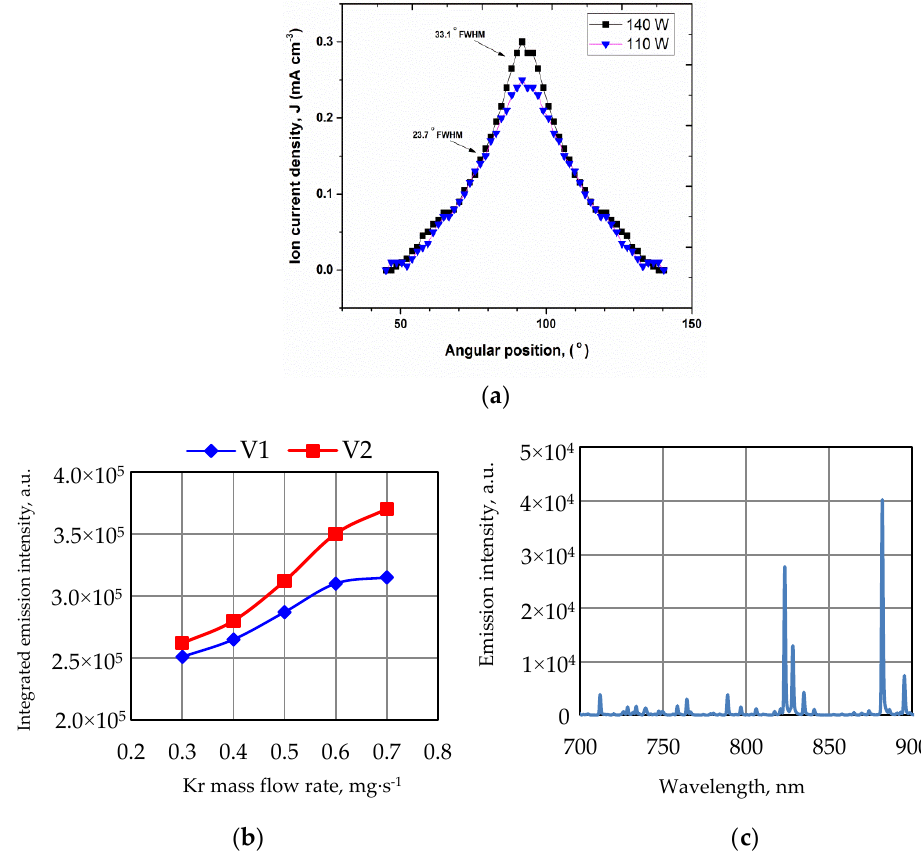
Figure 5. Plasma plume diagnostics for a Kr-fed low-power Hall thruster: ( a ) ion current density profiles for two operating conditions. © [2018] IEEE. Reprinted, with permission, from Lim et al., IEEE Transactions on Plasma Science 46, 2 (2018) [22]; ( b ) integrated optical emission intensity (300–1100 nm) as a function of the propellant flow rate, at two operating voltages 𝑉 1 = 150 V and 𝑉 2 = 200 V ; ( c ) raw infrared emission spectra for the thruster operating with Xe at 100 W.